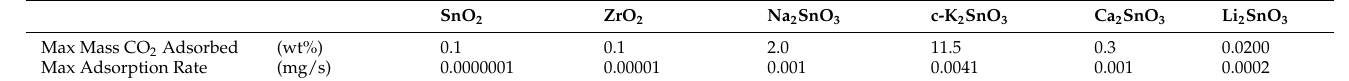
Table 1. Summary of stannates’ performance under dynamic CO 2 adsorption.